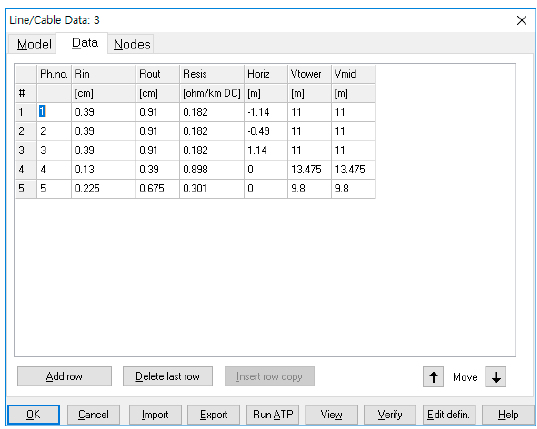
Figure 8. Example of LINE CONSTANTS in the electromagnetic transient program (EMTP).